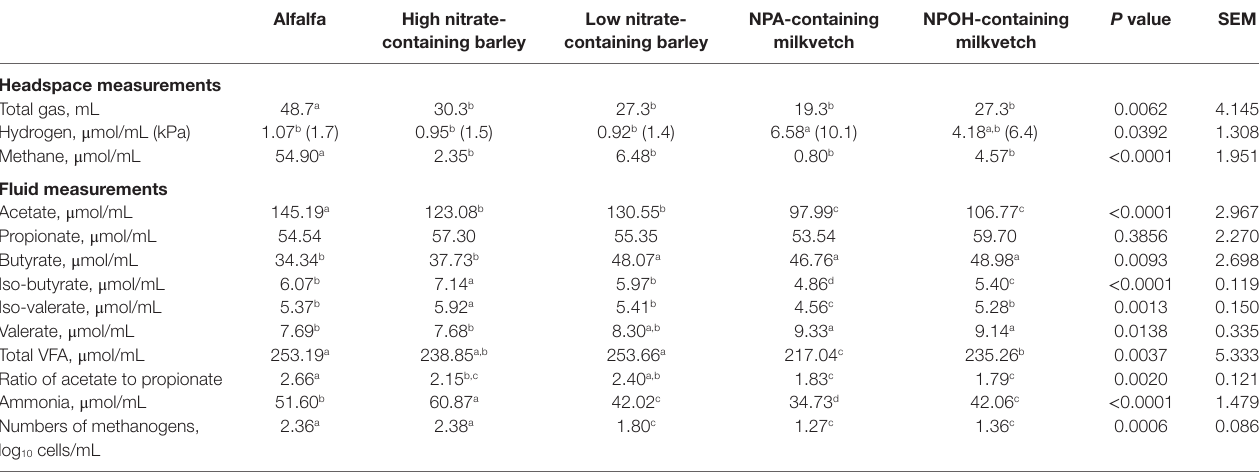
TaBle 3 | Fermentation characteristics of alfalfa and select nitrate- and nitro-containing forages during incubation with mixed cultures of ruminal microbes in experiment 2 with 50 mM added sodium formate and inoculation with Denitrobacterium detoxificans . alfalfa high nitrate- low nitrate- nPa-containing nPOh-containing P value seM containing barley containing barley milkvetch milkvetch headspace measurements Total gas,